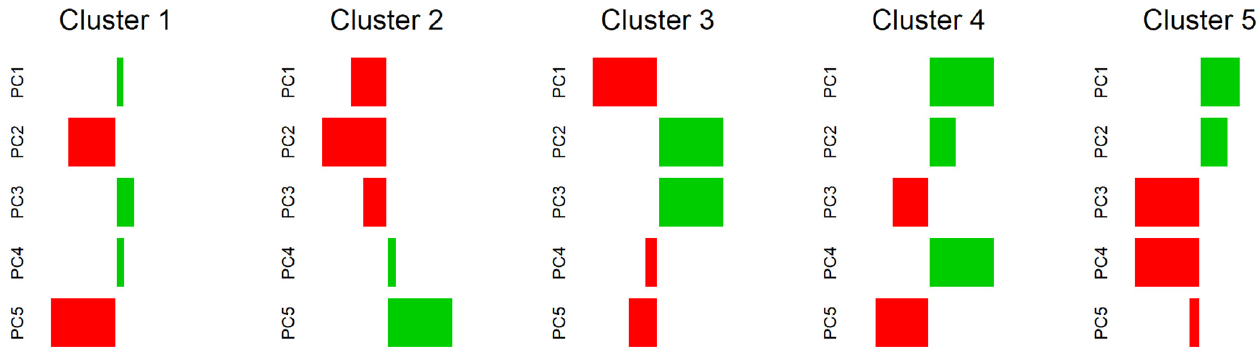
Figure 4. Mean scores for all the principal components of the respective clusters. Note: Green bars and red bars indicate positive and negative mean scores respectively. Longer bar indicates a higher absolute mean score.